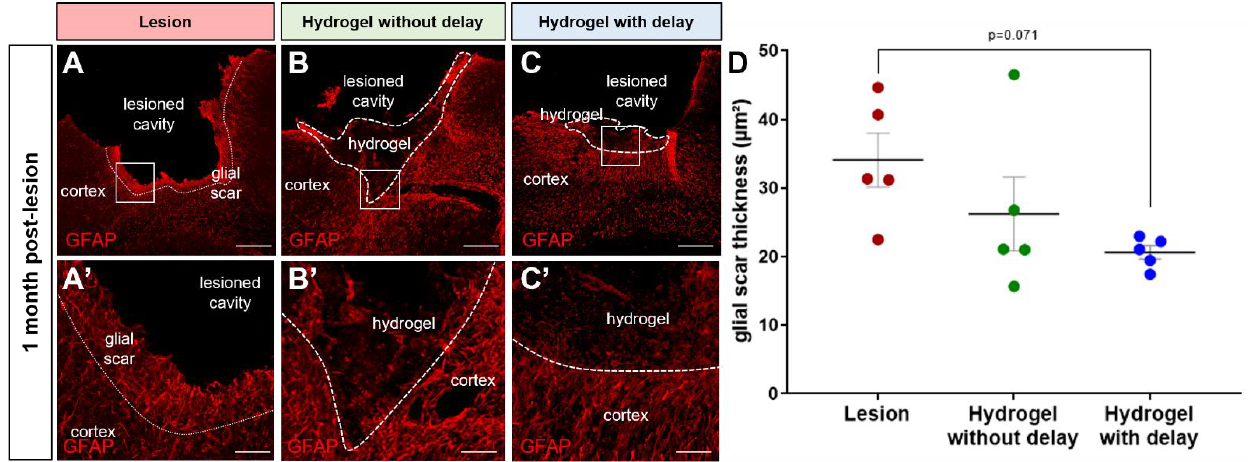
Figure 11. Glial scar thickness one month after the lesion/implantation. ( A – C ) Representative immunofluorescence images of GFAP+ cells (red) in lesioned ( A ) or delay ( B ) or no-delay ( C ) hydrogel implanted groups. Dashed lines indicate the limit of the glial scar ( A ) or hydrogel localization ( B , C ). The squares indicate the area of magnification. Scale bar: 200 μm. ( A ′ – C ′ ) High magnification images of the glial scar. Scale bar: 20 μm. ( D ) Quantitative analysis of the glial scar thickness in lesioned (red) in delay (green) or in no-delay (blue) hydrogel implanted groups. Groups were compared using one-way ANOVA, p = 0.07.